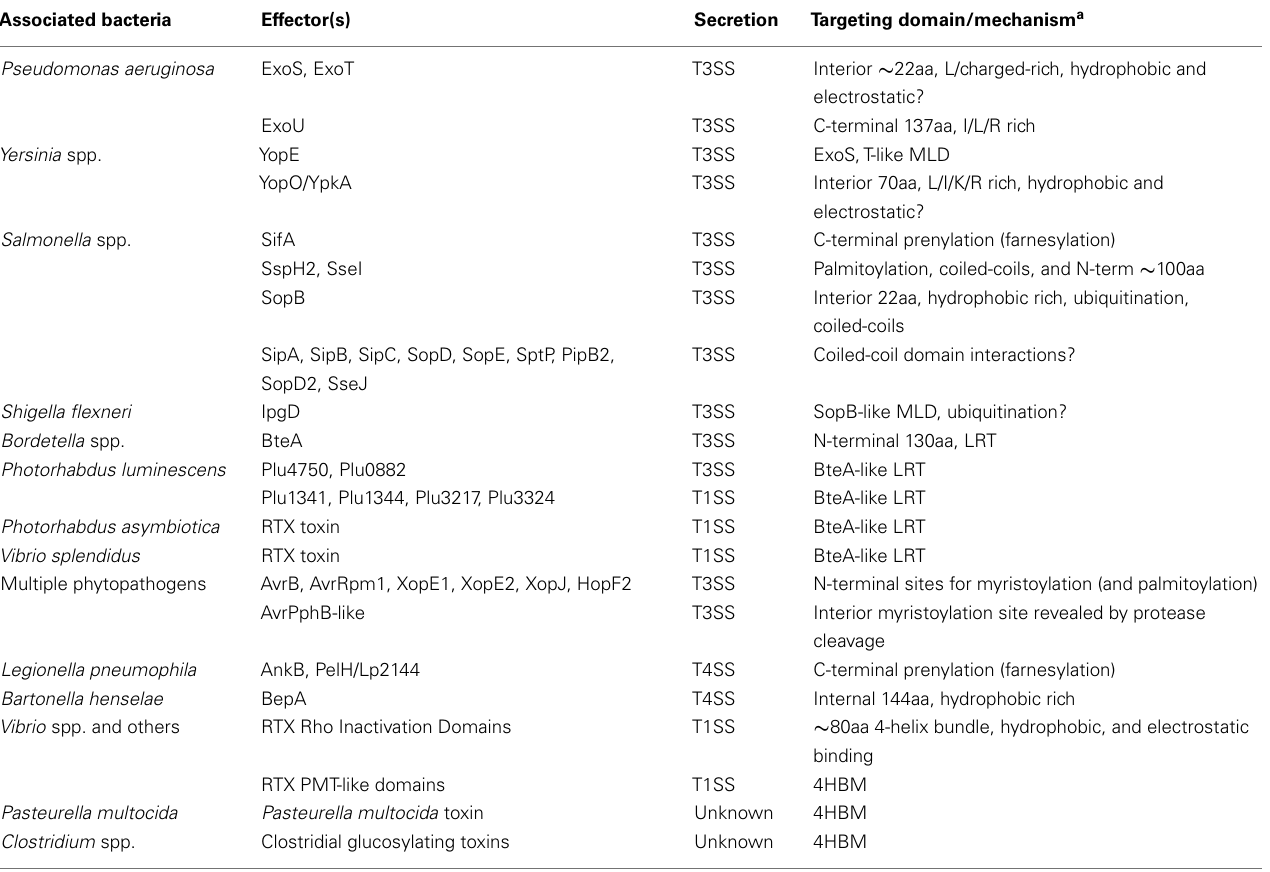
Table 1 | Plasma membrane-associated bacterial effectors and their mechanisms of targeting. Associated